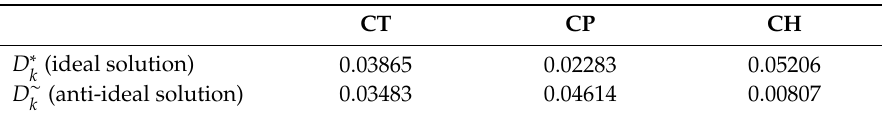
Table 5. The distance from the ideal and anti-ideal solution.